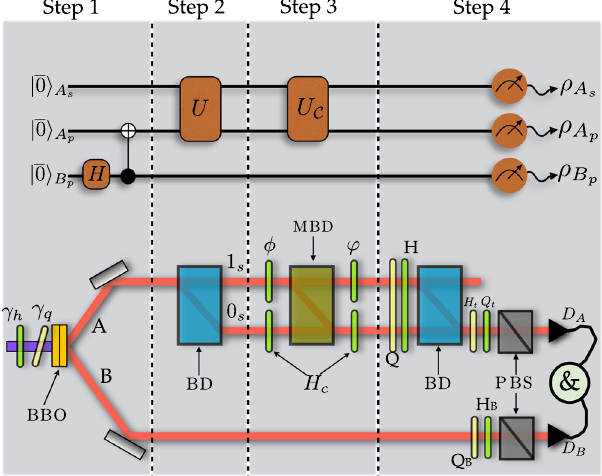
FIG. 2. Experimental setup. The top panel shows the quantum circuit employed in our experiment. In the main text, we give a complete description of each step in this circuit as well as its implementation in the optical scenario, shown in the bottom panel of the figure. The parameters α and β appearing in Eq. (B1) can be controlled by the half-wave ( γ ) and quarter-wave ( γ ) plates h q located before the BBO crystals. The MBD, in contrast with the ordinary BD, transmits the horizontal polarization and deflects the vertical one. Physically, it is implemented by placing a BD between two half-wave plates, which are not shown in the figure. The ϕ and φ plates are used to ensure identical path lengths in the interferometers. H and Q are half- and quarter-wave plates used i i in the tomographic process, as explained in the text, and the symbol & represents coincidence